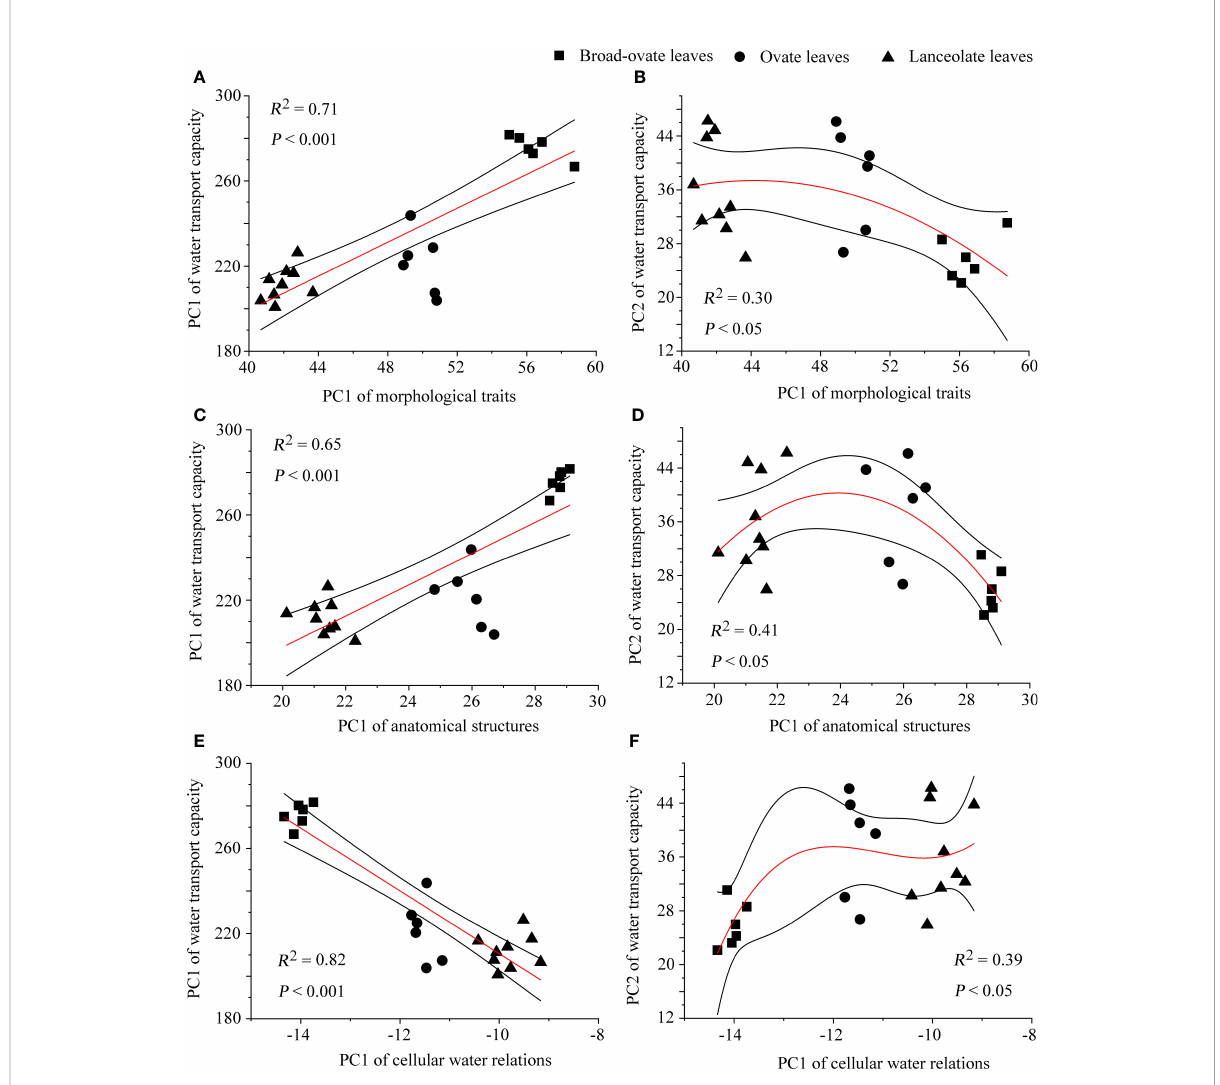
FIGURE 7 The fi tting of water transport capacity with morphological traits, anatomical structures, and cellular water relations. The relationships of PC1 of water transport capacity with the other categories are performed using linear fi tting, while those of PC2 are performed using exponential fi